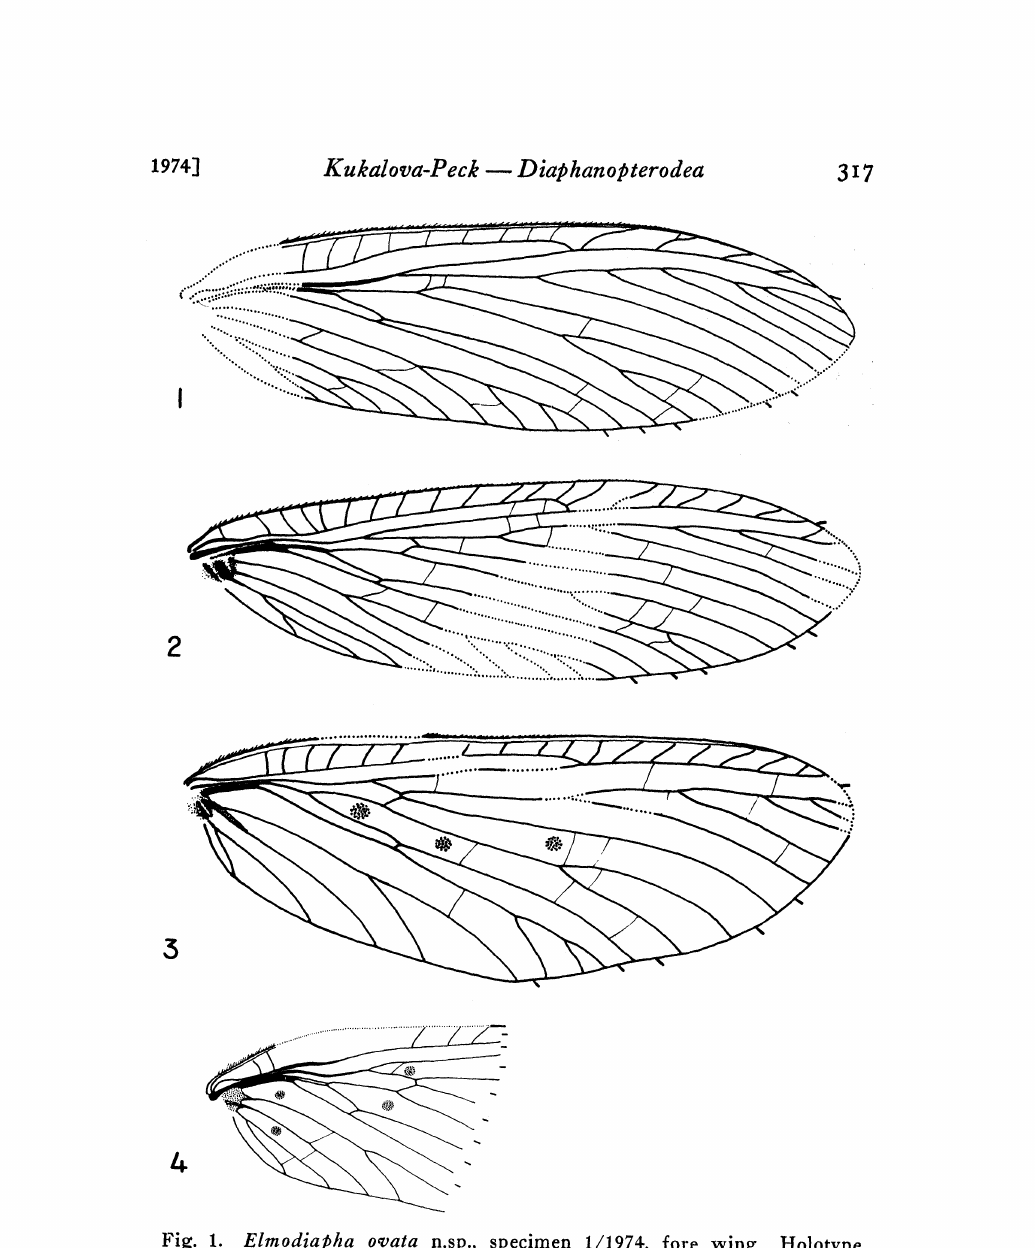
Fig. 1. Elmodialha oata n.sp., specimen 1/1974, fore wing. Holotype. Fig. 2. Elmodiapha oata n.sp., specimen 2/1974, fore wing. Fig. 3. Pro- todiapha maculi/era n.sp., specimen 3/1974, hind wing. Holotype. Fig. 4. Protodiapha maculi/era n.sp., specimen 4/1974, hind